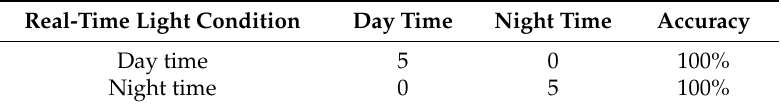
Table 5. Selection of light segmentation based on continuity of data matching.